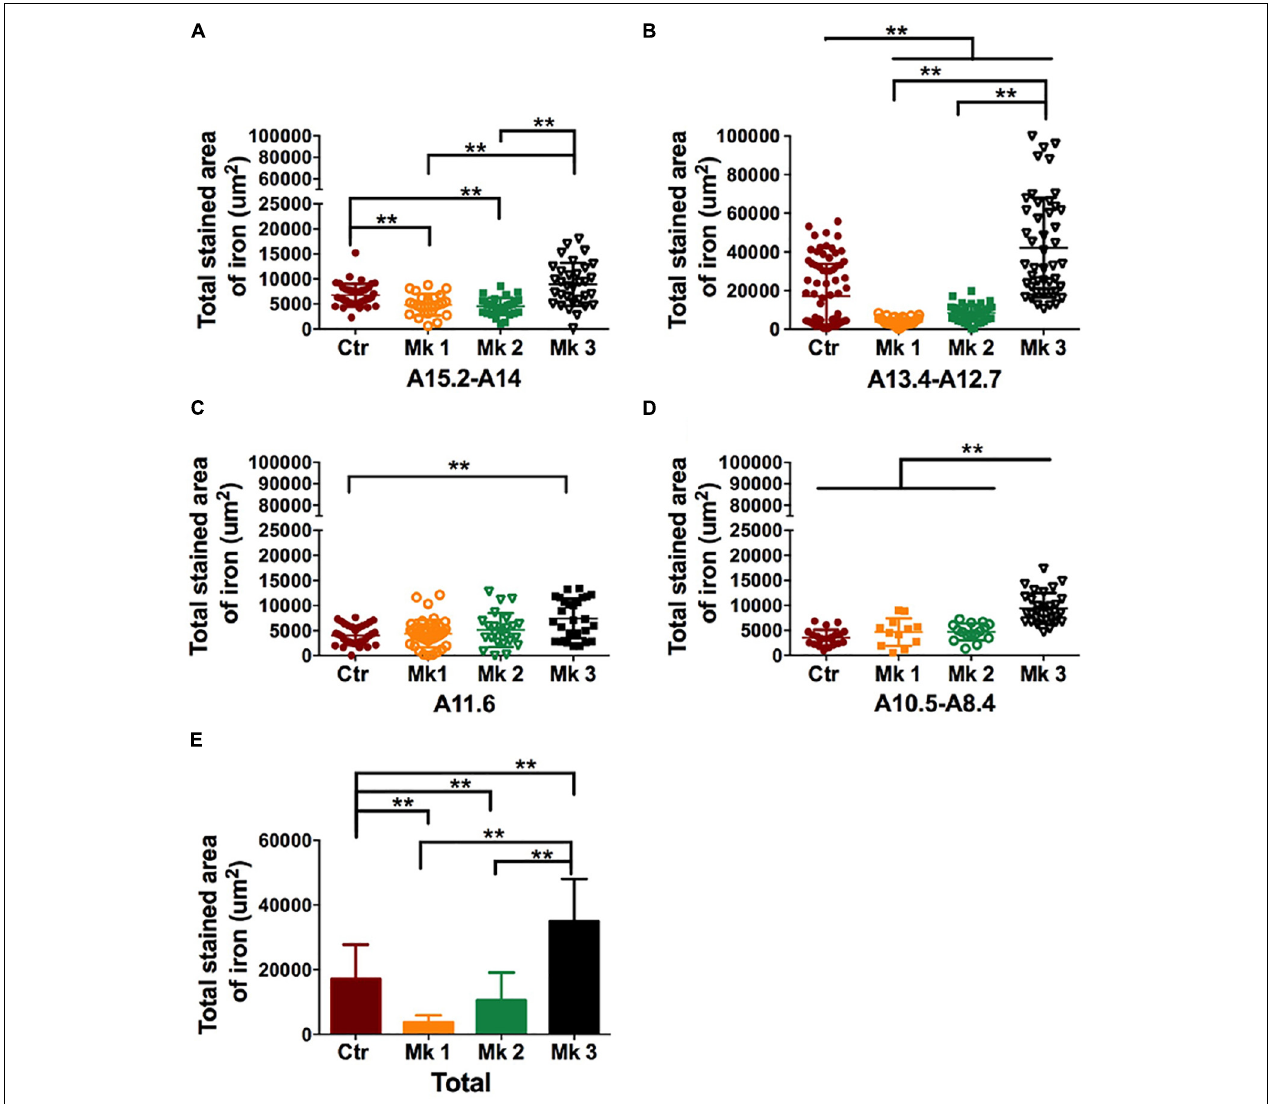
FIGURE 6 | Determination and comparison of iron accumulation in the SN in three MPTP-lesioned monkeys and in controlled monkeys. The data of Perls’ Prussian blue staining was collected and stereology analysis was carried out in four SN tiers for each monkey, A15.2-A14 (A) ; A13.4-A12.7 (B) ; A11.6 (C) , and A10.5-A8.4 (D) . Note that Perls’ Prussian blue staining was consistently elevated in Mk3 compared to control in all tiers. In addition, Perls’ Prussian blue staining in Mk3 was also significantly higher than Mk1 and Mk2 in tiers A15.2-A14 [ F (2,84) = 20.43, P < 0.0001], A13.4-A12.7 [ F (2,125) = 78.66, P < 0.0001] and A10.5-A8.4 [ F (2,55) = 22.07, P < 0.0001]. Interestingly, Perls’ Prussian blue staining was significantly lower in Mk1 and Mk2 in tier A15.2-A14 {Mk1,[ F (3,127) = 3.996, P = 0.0093]; Mk2,[ F (3,134) = 7.243, P = 0.0002]} and A13.4-A12.7 {Mk1, [ F (3,158) = 16.37, P < 0.0001]; Mk2, [ F (3,162) = 11.33, P < 0.0001]} when compared with control. (E) : A comparison of Perls’ Prussian blue staining area in each monkey when the data were pooled together from all the SN tiers. Analysis showed that Perls’ Prussian blue staining area in the SN of Mk3 was significantly elevated when compared to control [ F (3,441) = 18.81, P < 0.0001] and to that of Mk1 and 2 [ F (2,362) = 47.4, P < 0.0001]. Interestingly, Perls’ Prussian blue staining areas in Mk1 [ F (3,427) = 13.04, P < 0.0001] and Mk2 [ F (3,434) = 8.621, P < 0.0001] were significantly reduced when compared to control. ANOVA, ∗ P < 0.05, ∗∗ P <